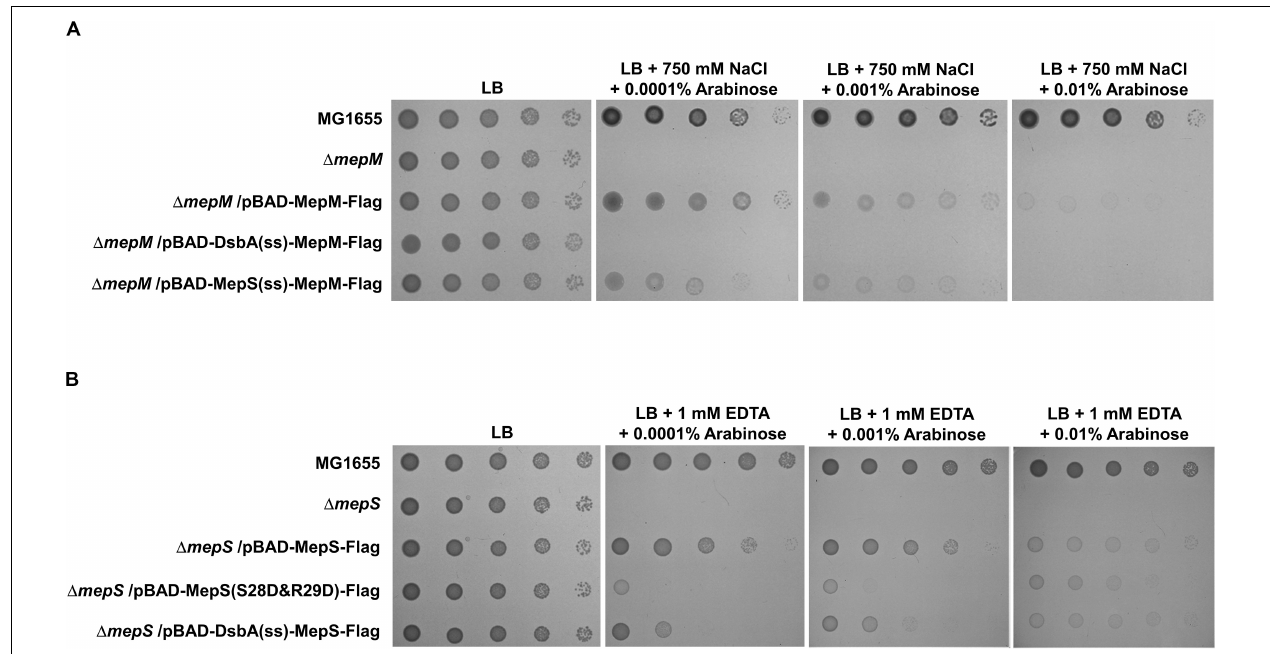
FIGURE 3 | The importance of the localization of MepM and MepS on their function. (A) The wild-type, mepM mutant, and mepM mutant cells harboring the indicated plasmids were serially diluted from 10 8 to 10 4 cells/mL in 10-fold steps and spotted onto an LB plate or LB plates containing 750 mM NaCl and the indicated concentrations of arabinose. (B) The wild-type, mepS mutant, and mepS mutant cells harboring the indicated plasmids were serially diluted from 10 8 to 10 4 cells/mL in 10-fold steps and spotted onto an LB plate or LB plates containing 1 mM EDTA and the indicated concentrations of